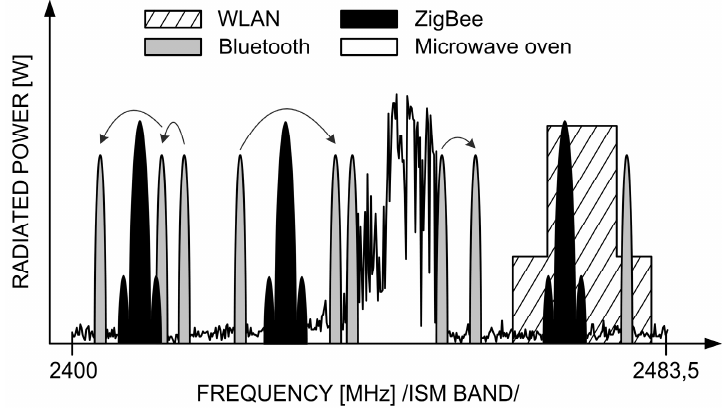
Figure 8. Technological congestion in the ISM band [16].